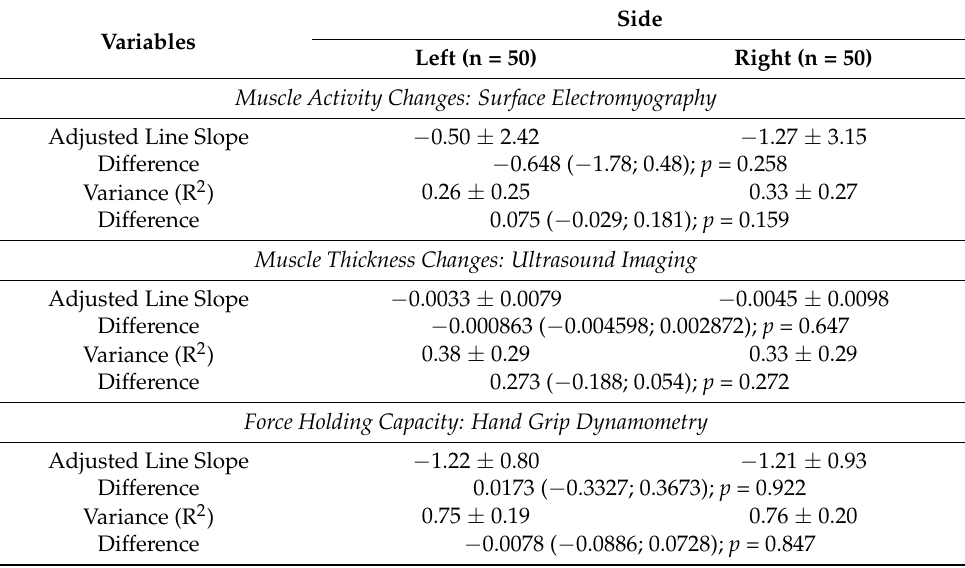
Table 4. Fatigue assessments with EMG, US and dynamometry by